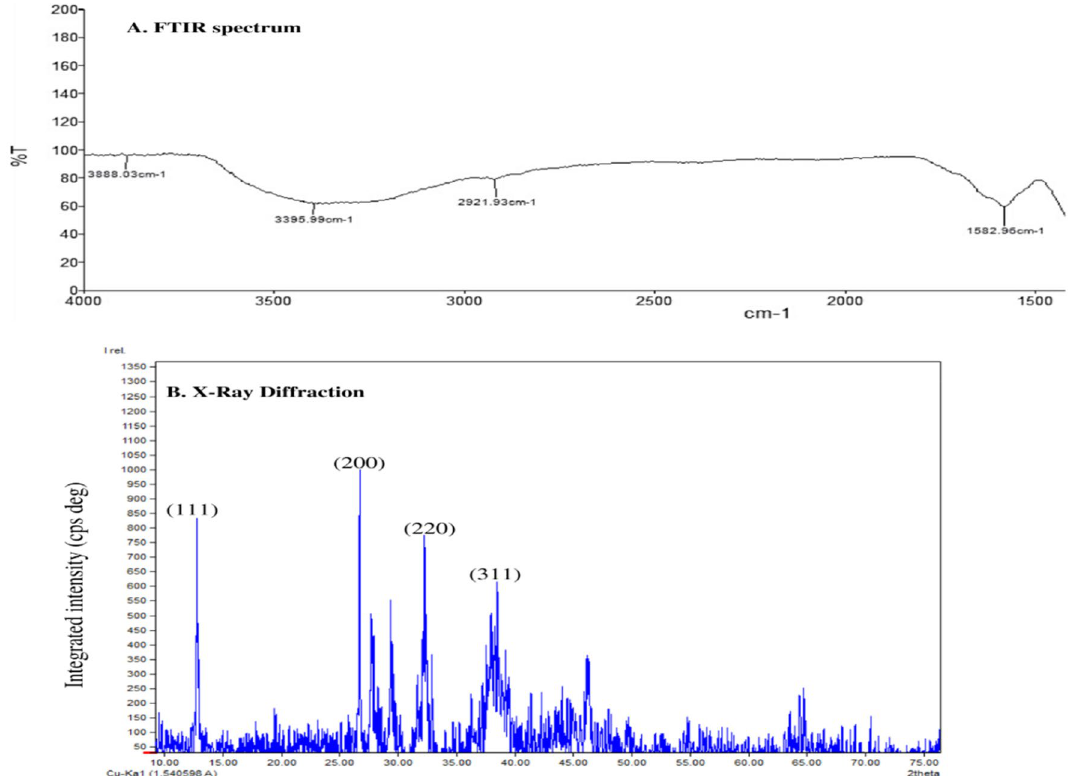
Figure 4. ( A ) Analysis of Silver nanoparticles using FTIR spectrum of Sargassum polycystum. ( B ) Analysis of Silver nanoparticles using X-Ray Diffraction of Sargassum polycystum.